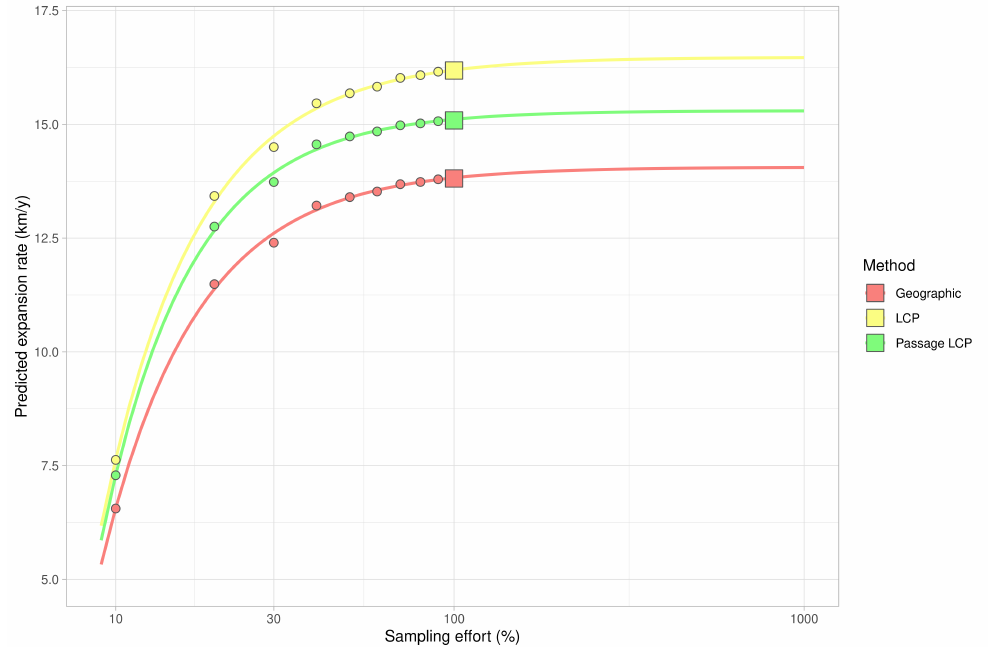
Figure 6. Estimates of expansion rate in decreasing and increasing sampling effort based on Weibull four-parametric dose-response